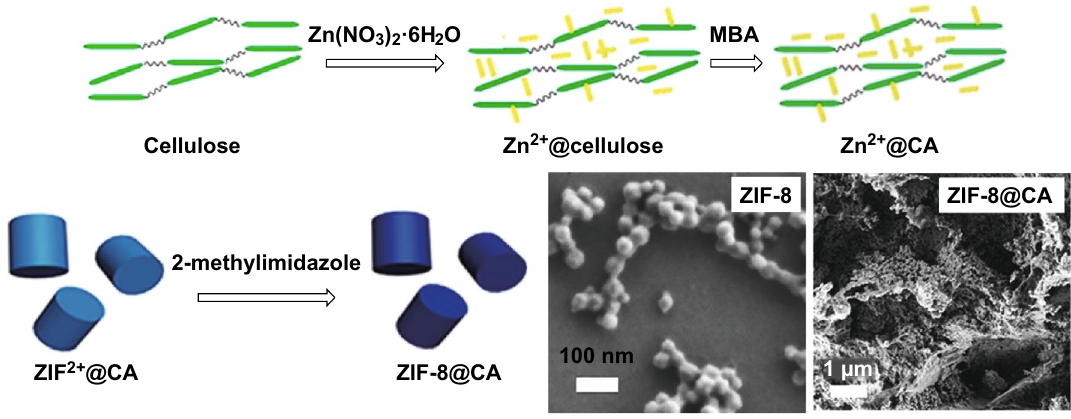
Fig. 5 Schematic illustrations showing the preparation of ZIF-8@CA and the resulting SEM images. Reprinted with permission from Ref. [74]. Copyright 2018 Elsevier Inc